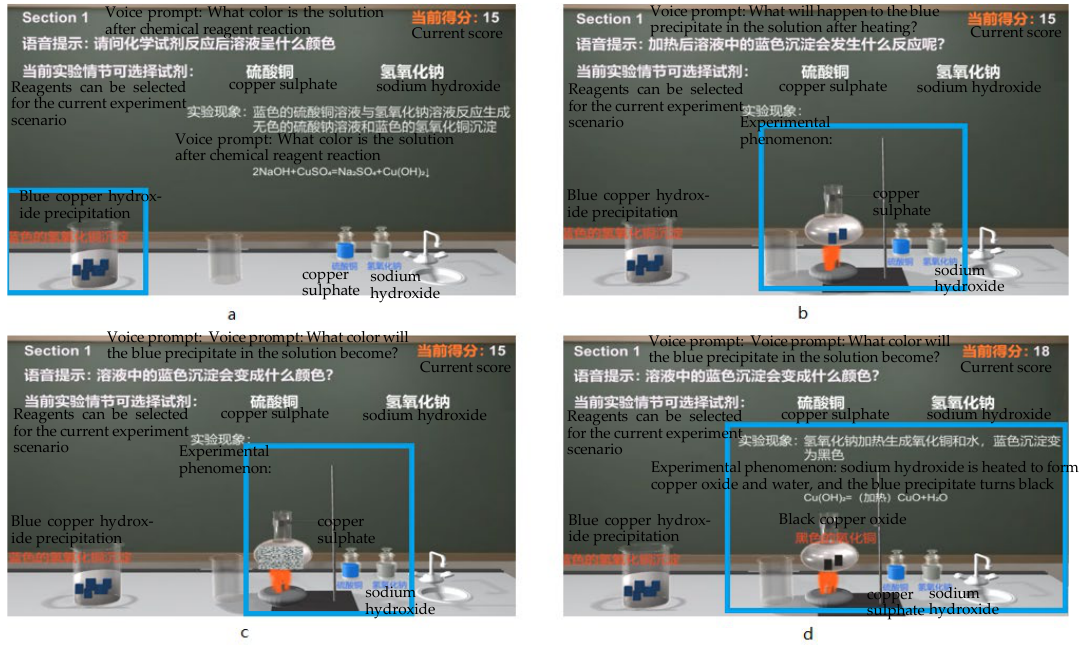
Figure 13. Copper sulfate reacts with sodium hydroxide solution 2. ( a ). Experimental phenomenon question and answer interface 1. ( b ). Experimental phenomenon question and answer interface 2. ( c ). Experimental phenomenon question and answer interface 3. ( d ). Experimental phenomenon question and answer interface 4.